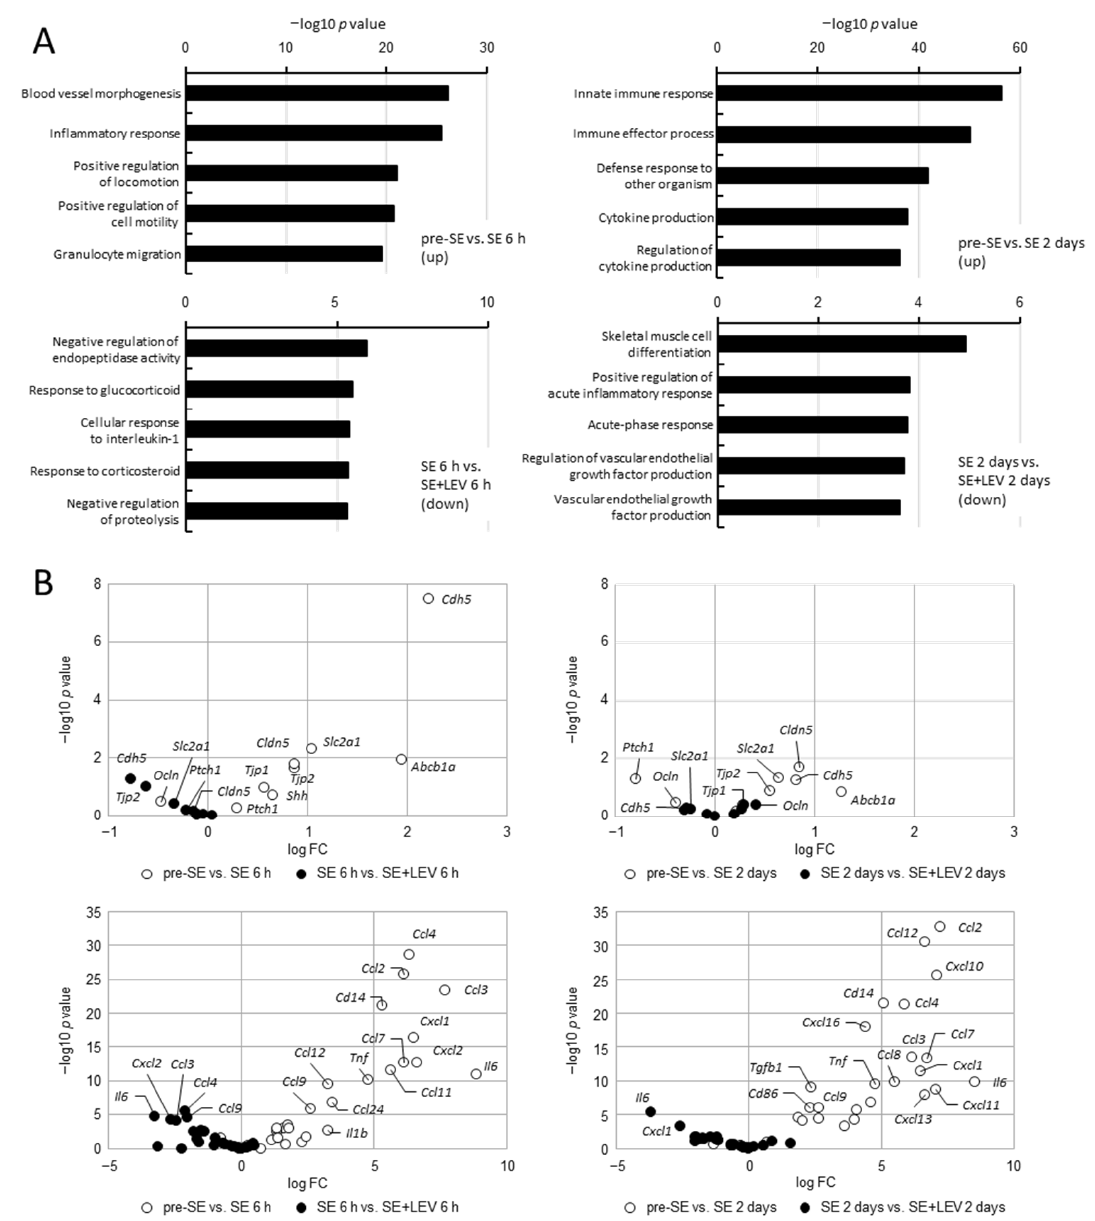
Figure 1. Comprehensive analysis of variable-expression genes after PILO-SE. ( A ) Functional annotation of upregulated genes in the hippocampus of PILO-SE mice (upper panels) and those with upregulation that was prevented after LEV treatment (lower panels) at 6 h and 2 days after SE. Total RNA was extracted from the hippocampi of mice treated with PILO after 6 h and 2 days (post-SE) or before SE (pre-SE), and cap analysis of gene expression (CAGE) and gene ontology (GO) enrichment analysis were performed. Two mice were used in each group. The top five GO terms in each group are displayed. The x -axis shows the − log10 p value, such that a higher value indicates greater significance. ( B ) Volcano plot showing differences in the expression levels of typical factors that influence BBB function (upper panels) and cytokine/chemokine (lower panels) between pre- and post-SE (open circle) or in animals treated with LEV or untreated (filled circle) at 6 h (left panels) and 2 days (right panels) after SE. The x -axis shows the fold change values (log2) between two experimental groups, and the y -axis shows the − log10 p